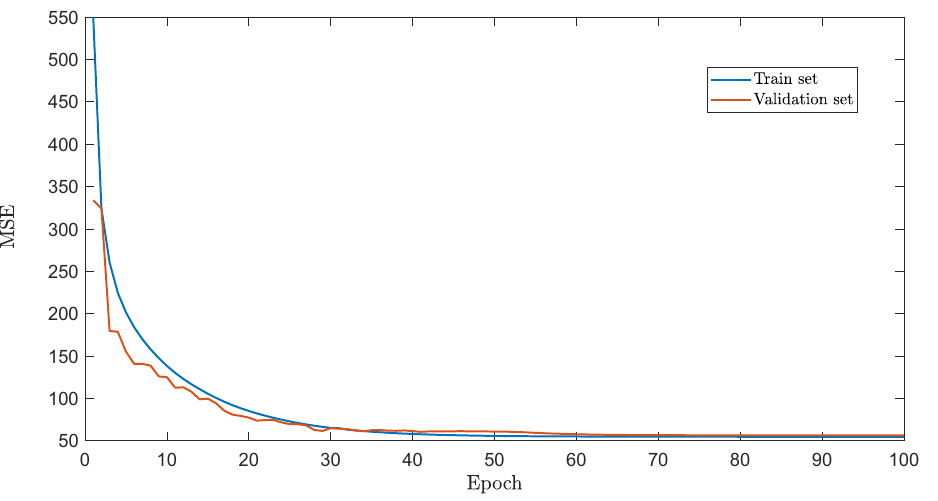
Figure 5. Training history for